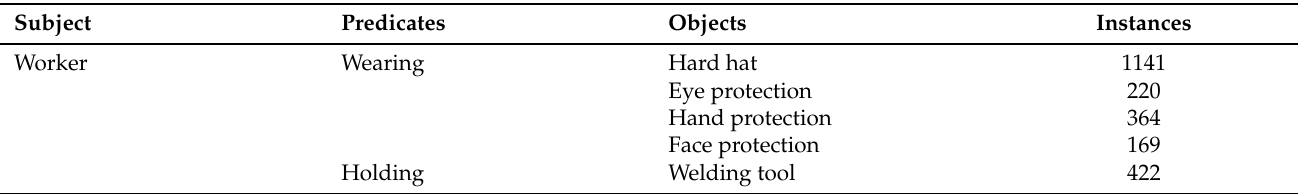
Figure 6. Interface and storage format of the image annotation. Table 4. Visual relation annotations